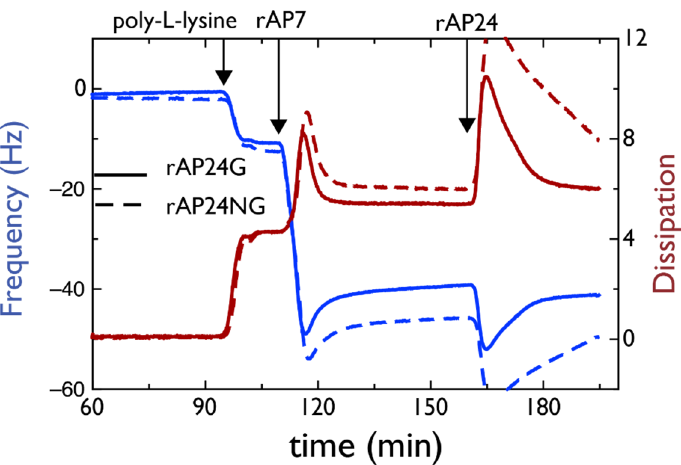
Figure 2. QCM-D experiments of immobilized rAP7 (500 nM in 10 mM HEPES pH 8.0) exposed to either 500 nM rAP24G (solid lines) or 500 nM rAP24NG (dashed lines) in 10 mM HEPES, pH 8.0. Plots show the third harmonic frequency (F3, blue) and dissipation (D3, red) observed under each scenario. For more information on the QCM-D method and experimental protocol, please refer to [28]. rAP7 is adsorbed onto the poly-L-Lys coated QCM-D chip, then unbound rAP7 is washed off and then rAP24G (glycosylated) or rAP24NG (non-glycosylated) variants are introduced into the flowcell. Deflection in frequency and dissipation result from rAP24 protein adsorbing onto the immobilized rAP7 layer on the chip, with amplitudes of the deflection proportional to the amount of protein bound. The time-dependent introduction of proteins is noted on the plots by arrows. These experiments were repeated and found to be